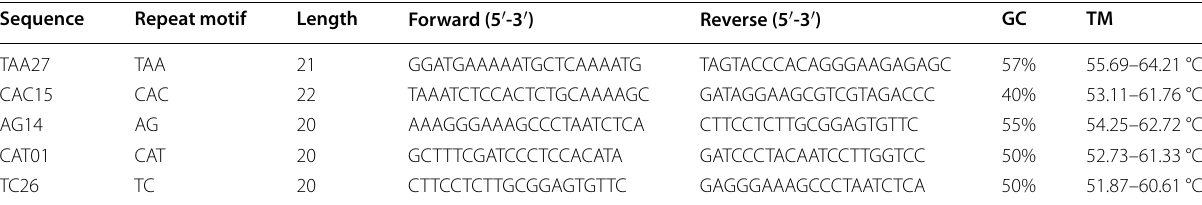
Table 2 SSR loci primers used on sweet orange genotype studied. The primer sequences are based on Liu et al. [16] Sequence Repeat